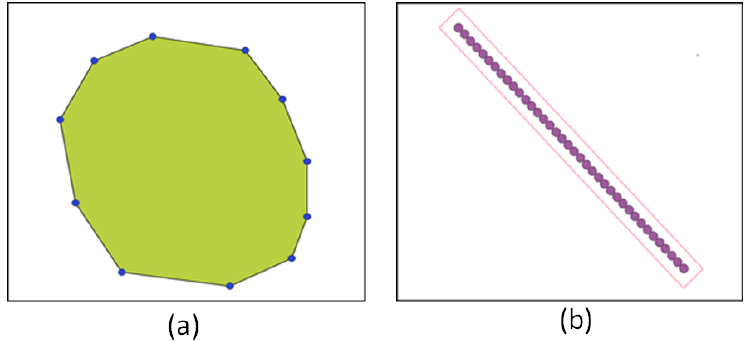
Figure 16. ( a ) Extent of a NFZ or PPZ within a layer—only the blue vertices are stored in the database; ( b ) edge of a drone path—spatial extent is stored by the outer quadrilateral and spatial–temporal components are stored in the points along the edge.